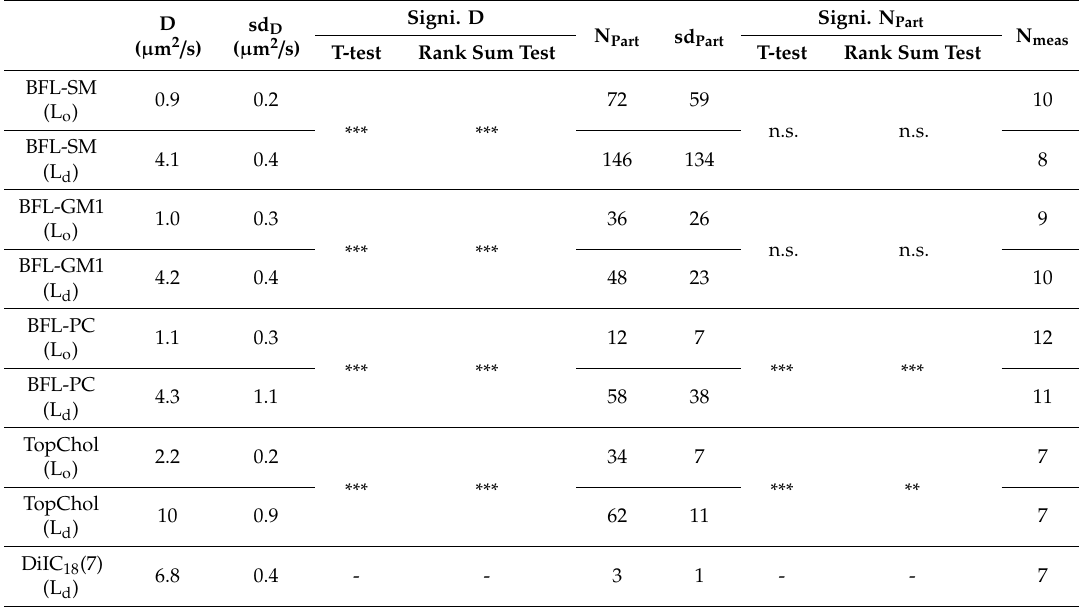
Table 2. Characteristic di ff usion parameters of di ff erent fluorescent membrane tracers determined by FCS in the liquid ordered (L o ) and liquid disordered (L d ) phases of GUVs. Signi. D Signi. N Part D sd D N Part sd Part N meas ( µ m 2 / s) ( µ m 2 / s) T-test Rank Sum Test T-test Rank Sum